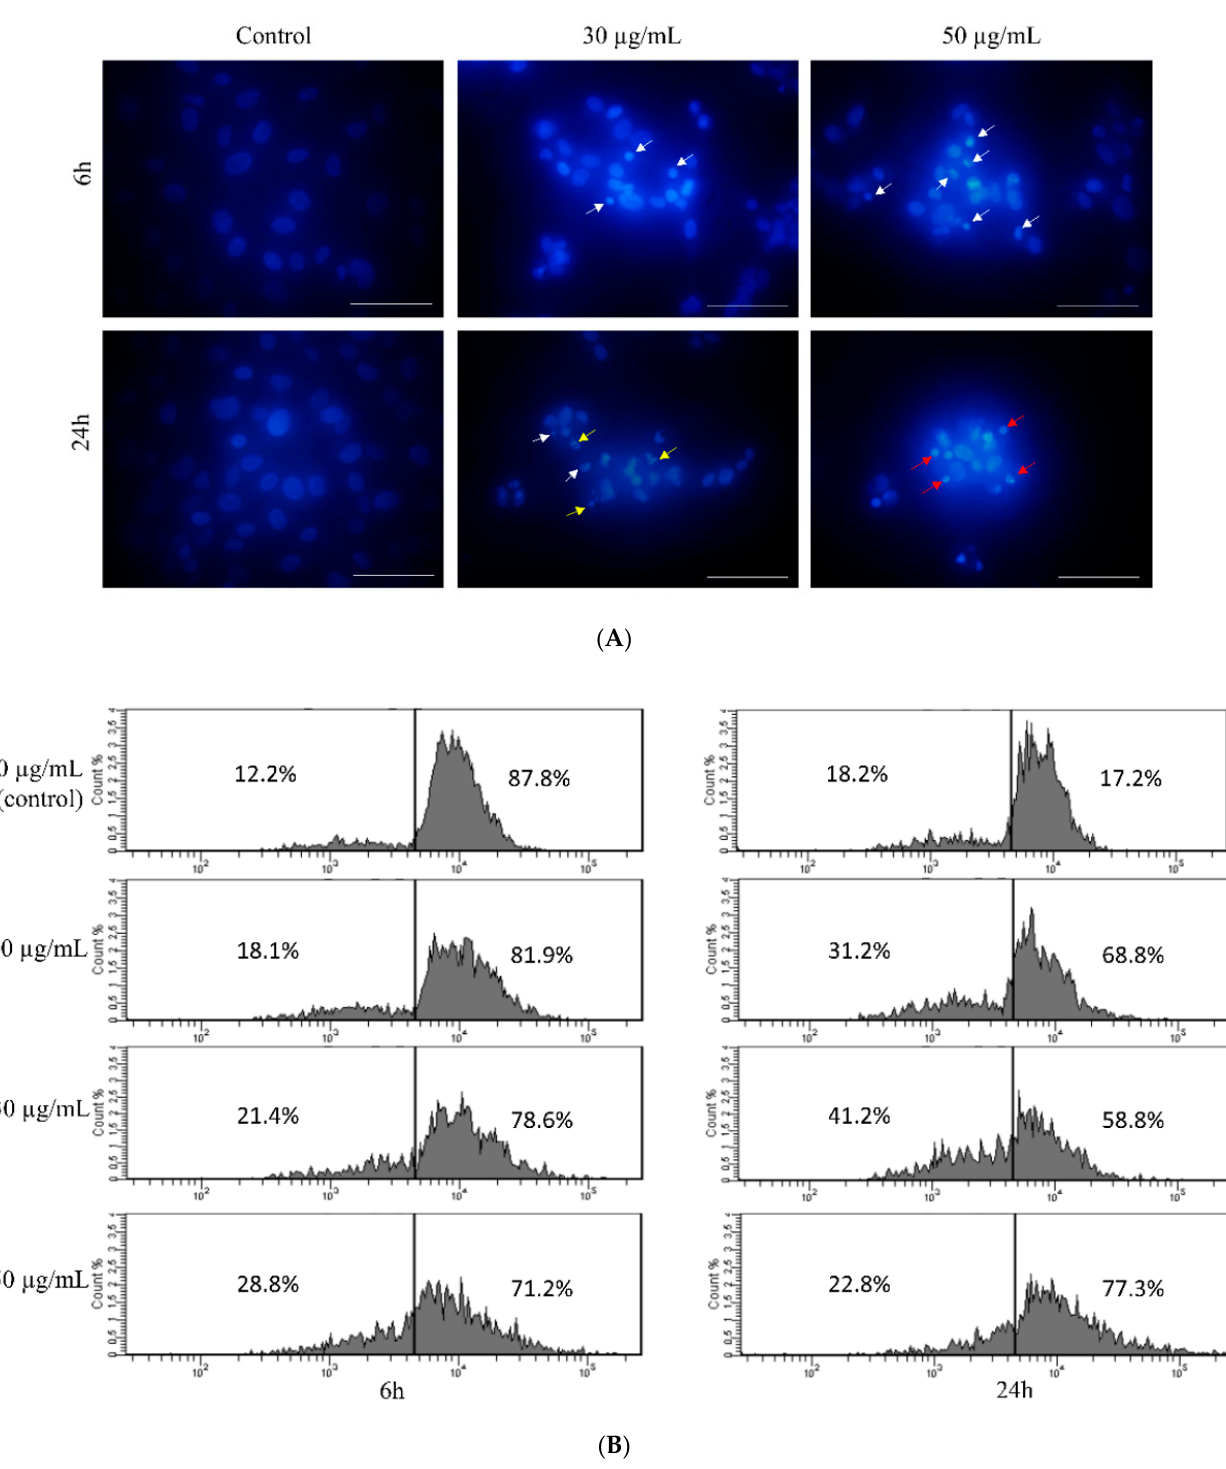
Figure 3. Changes in nuclear morphology of HT-1080 cells after treatment with star polymer. ( A ) DAPI-stained nuclei of HT-1080 cells after treatment with star polymer. In untreated cells, nuclei are large and chromatin is uncondensed. In treated cells shrinkage of nucleus and chromatin condensation are observed. Nuclei with condensed chromatin (early stage of apoptosis) is indicated by white arrows. Fragmented nuclei are indicated by yellow arrows and nuclei with a ring-like shape are indicated by red arrows. Scale bar represents 50 µ m. ( B ) Flow cytometry analysis of DNA content in HT-1080 cells treated with star polymer for 6 h (left panel) and 24 h (right panel). Percentage of positive cells are presented on each